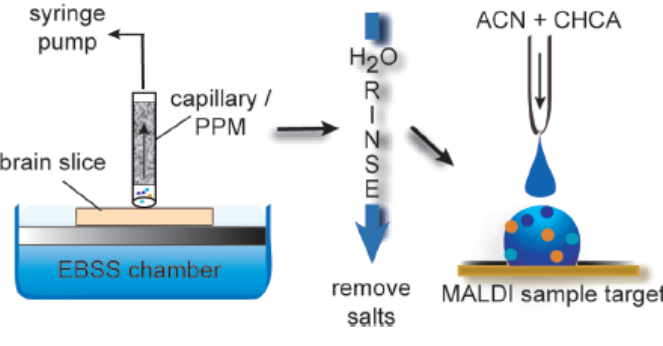
Figure 13. Scheme showing the sampling process from a mouse brain slice using a capillary loaded with PPM; the individual steps shown include peptide collection, a monolith rinse and peptide deposition onto the matrix-assisted laser desorption/ionization (MALDI) target for MS characterization [145]. Reprinted with permission from the American Chemical Society.